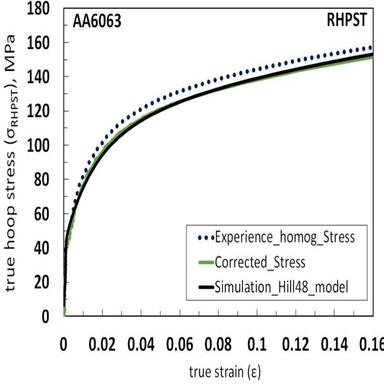
Comparison of the experimental RHPST stress–strain curve (solid red dots), the GRHPST-corrected curve, and the predicted curve simulated using the Hill48 yield criterion.